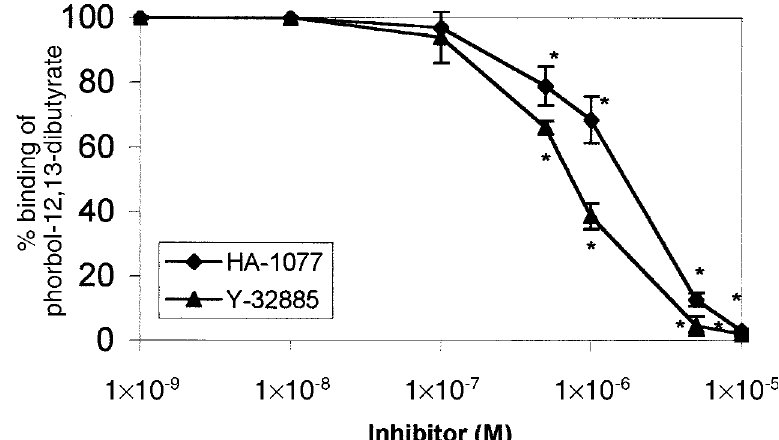
FIG. 3. Action of HA-1077 and Y-32885 on the binding of phorbol-12,13-dibutyrate with PKC. The proteins were incubated with the compounds at 30°C for 10min. Phorbol ester was then added to the samples for 15min at 30°C, and the residual radioactivity was measured by a scintillation counter. Non-specific binding was determined by cold phorbol-12,13-dibutyrate. Results are the mean ± SEM of six experiments. Significant difference versus the reference was evaluated by Student’s t -test, p < 0.05.